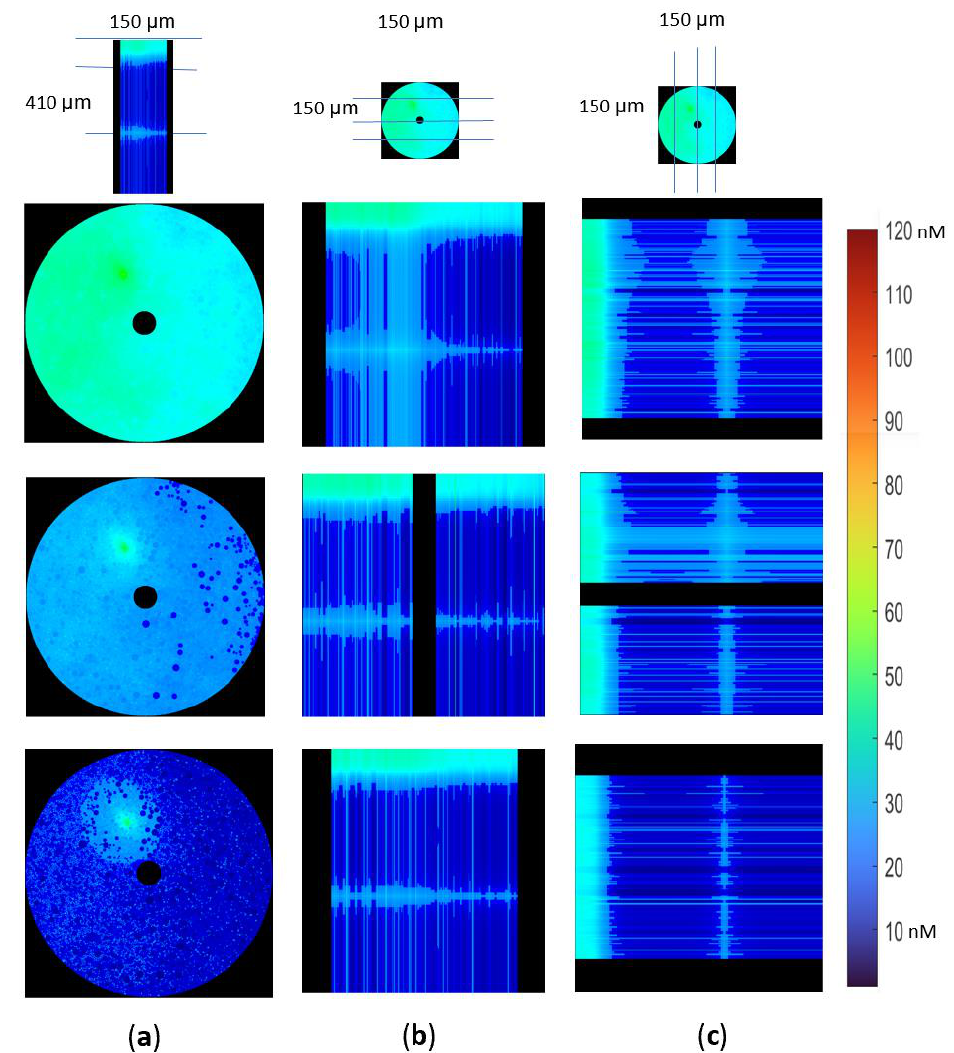
Figure 8. Models with unmyelinated and myelinated regions have peak [H 2 O 2 ] in the unmyelinated regions and higher concentrations close to the nodes of Ranvier than in the internodal regions when scavenging in the internodal regions is lower than in the rest of the model (P m = 20 µm s −1 , 30% reduction in scavenging capacity in the internodal regions). ( a ) The coronal plane cuts show the [H 2 O 2 ] at 3 distinct Z locations along the axon; ( b ) Transverse views of [H 2 O 2 ] gradients in the unmyelinated and myelinated regions; ( c ) Sagittal view of [H 2 O 2 ] and the differences between unmyelinated and myelinated regions.